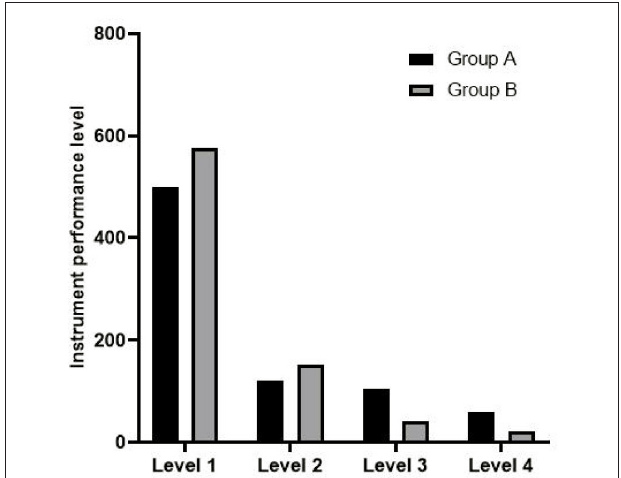
FIGURE 2 | Comparison of instrument performance grade between two groups.